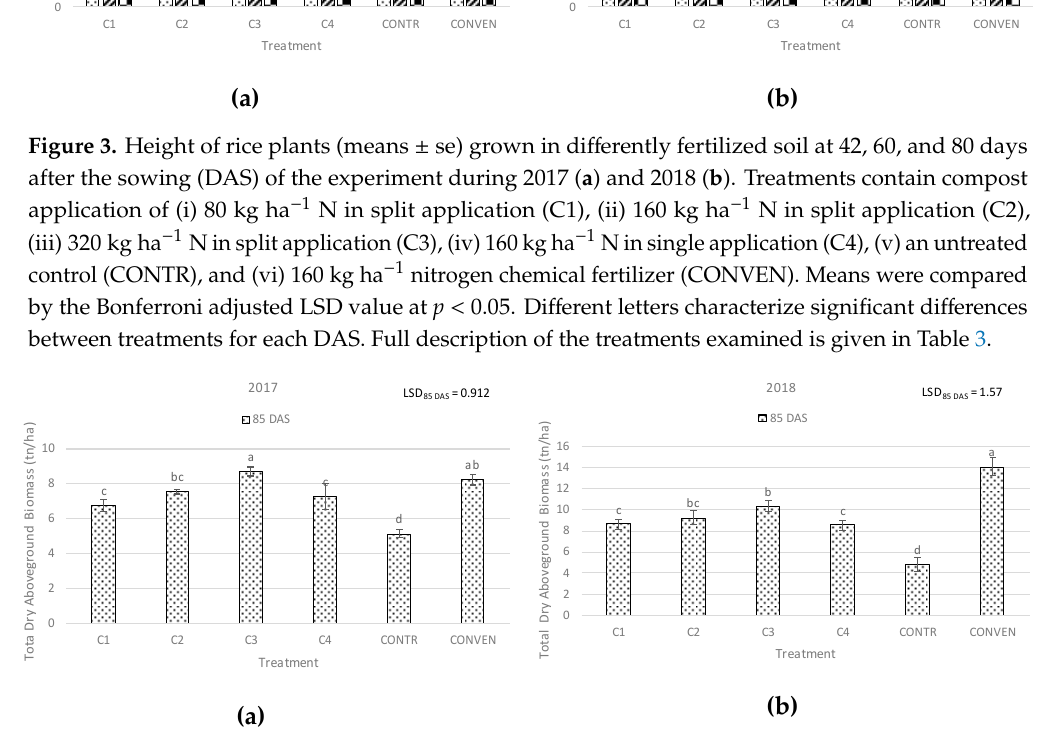
Figure 4. Total dry aboveground biomass of rice plants (means ± se) grown in differently fertilized soil at 85 days after the sowing (DAS) of the experiment during 2017 ( a ) and 2018 ( b ). Treatments contain compost application of (i) 80 kg ha − 1 N in split application (C1), (ii) 160 kg ha − 1 N in split application (C2), (iii) 320 kg ha − 1 N in split application (C3), (iv) 160 kg ha − 1 N in single application (C4), (v) an untreated control (CONTR), and (vi) 160 kg ha − 1 nitrogen chemical fertilizer (CONVEN). Means were compared by the Bonferroni adjusted LSD value at p < 0.05. Di ff erent letters characterize significant di ff erences between treatments. Full description of the treatments examined is given in Table